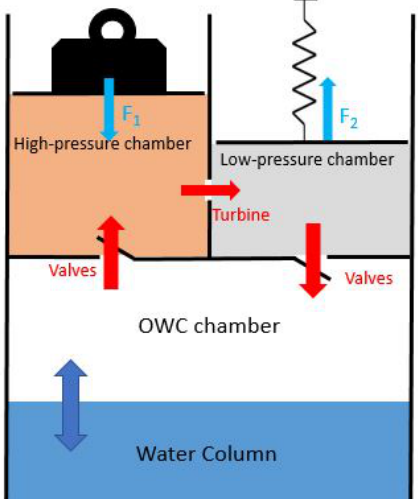
Figure 8. Schematic diagram of the Uilleann WEC